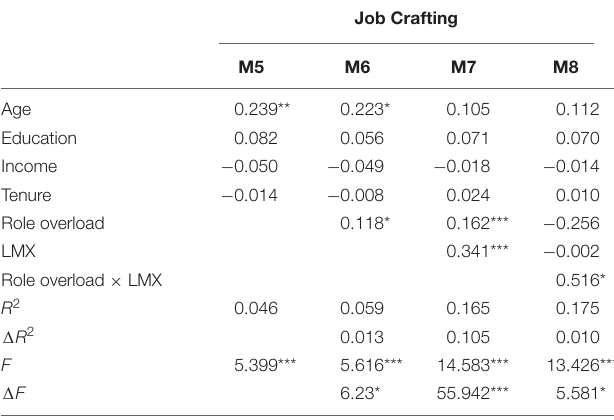
TABLE 5 | Regression analyses for the effect of perceived role overload and job